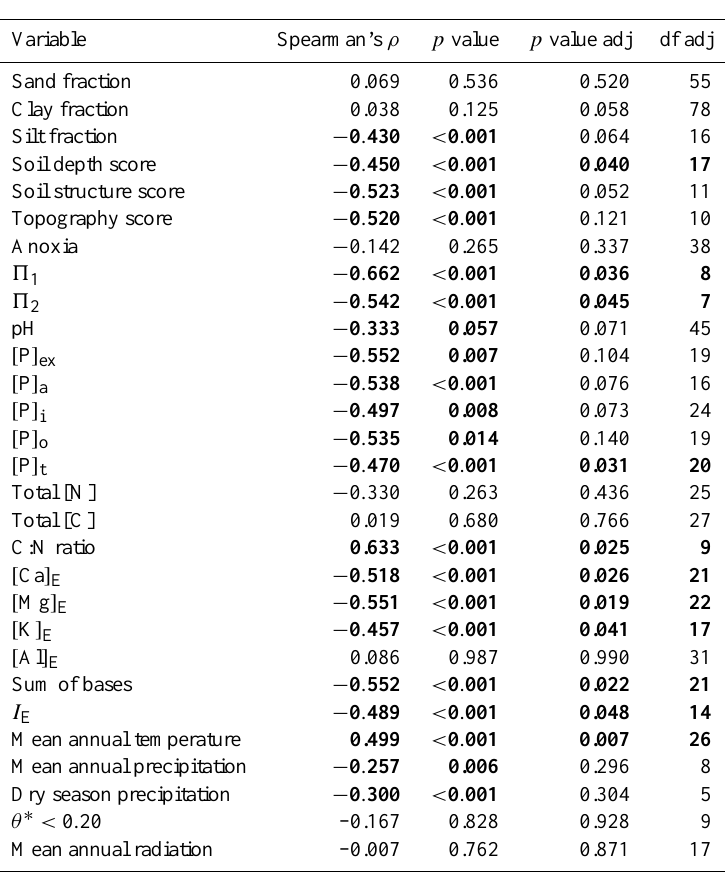
Table 3. Spearman’s ρ for relationships between stand-level wood density and a range of soil and climate predictors. Probabilities ( p ) are given with and without adjustment (adj) for degrees of freedom (df) according to Dutillieul (1993). Abbreviations used: 5 1 and 5 2 – first and second indices of soil physical conditions (Sect. 2.2); [ P ] ex , [ P ] a , [ P ] i , [ P ] o , [ P ] t – extractable, available, inorganic, organic and total soil phosphorus pools; [ Ca ] E , [ Mg ] E , [ K ] E , [ Al ] E - exchangeable calcium, magnesium, potassium and aluminium concentrations; I E – effective soil cation exchange capacity; θ ∗ < 0 . 20 – modelled number of months with soil water less than 0.2 of maximum available soil water content. Where p ≤ 0 . 050 values are shown in